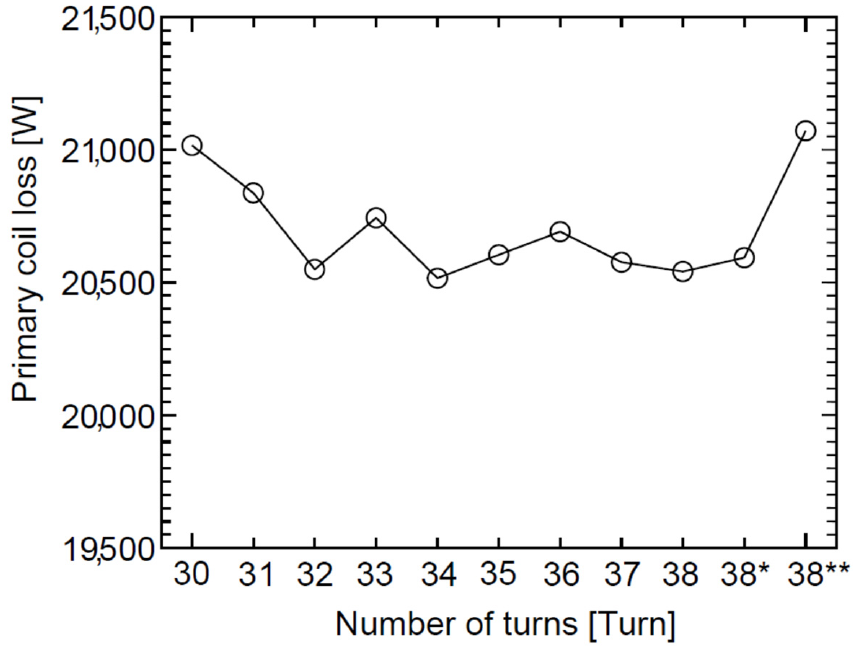
Figure 5. The primary coil loss when the secondary winding changes.